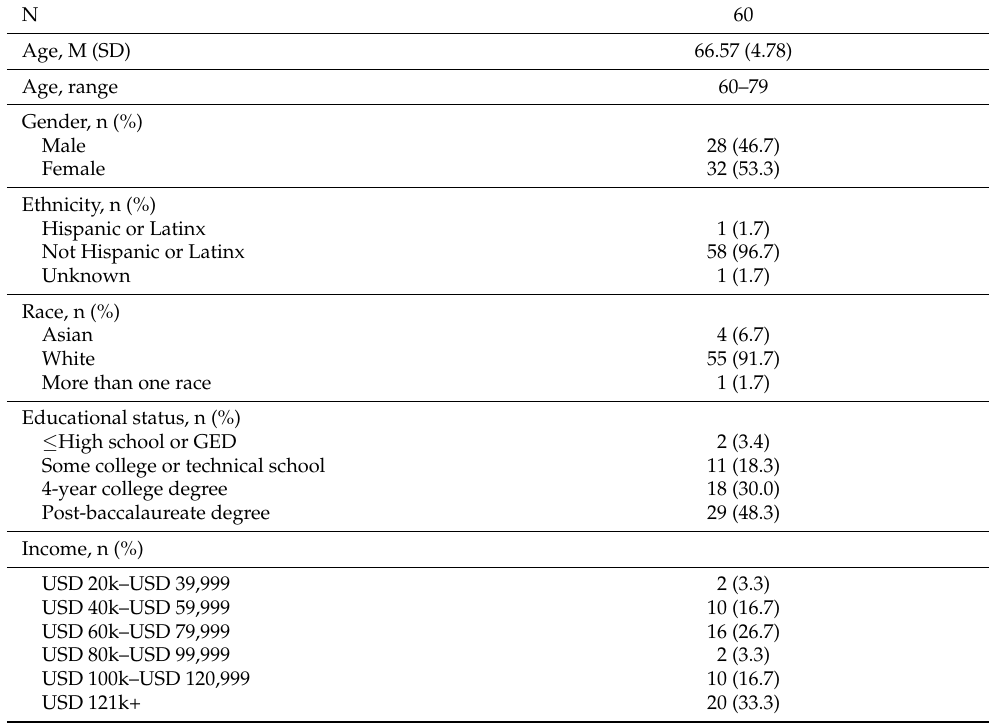
Table 1. Demographic characteristics of the sample.